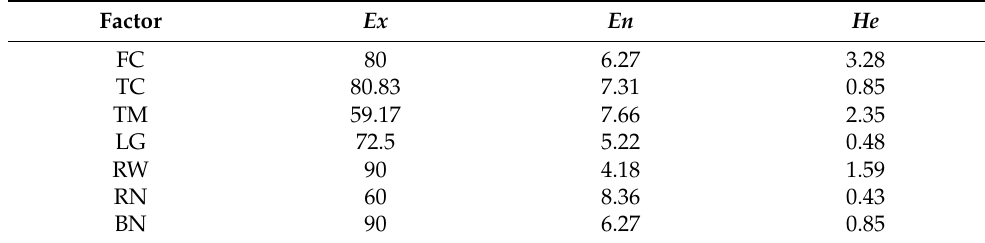
Table 5. The descriptive statistics of cloud models.